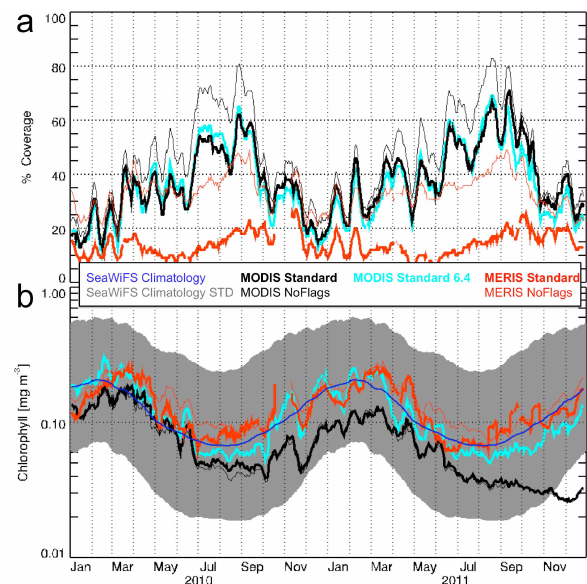
Fig. 4. MODIS and MERIS 2010–2011 time series; (a) the per- centages of good pixels with respect to all sea pixels for both standard(thin) and NoFlags(bold) daily data are marked in red for MERIS and in black for MODIS; (b) average daily chlorophyll concentration for standard(thin), NoFlags(bold) and SeaWiFS cli- matology(blue). The grey area identifies the ± one climatological STD with respect to daily average SeaWiFS climatology. For de- tails about climatology, see Sect. 3.2.